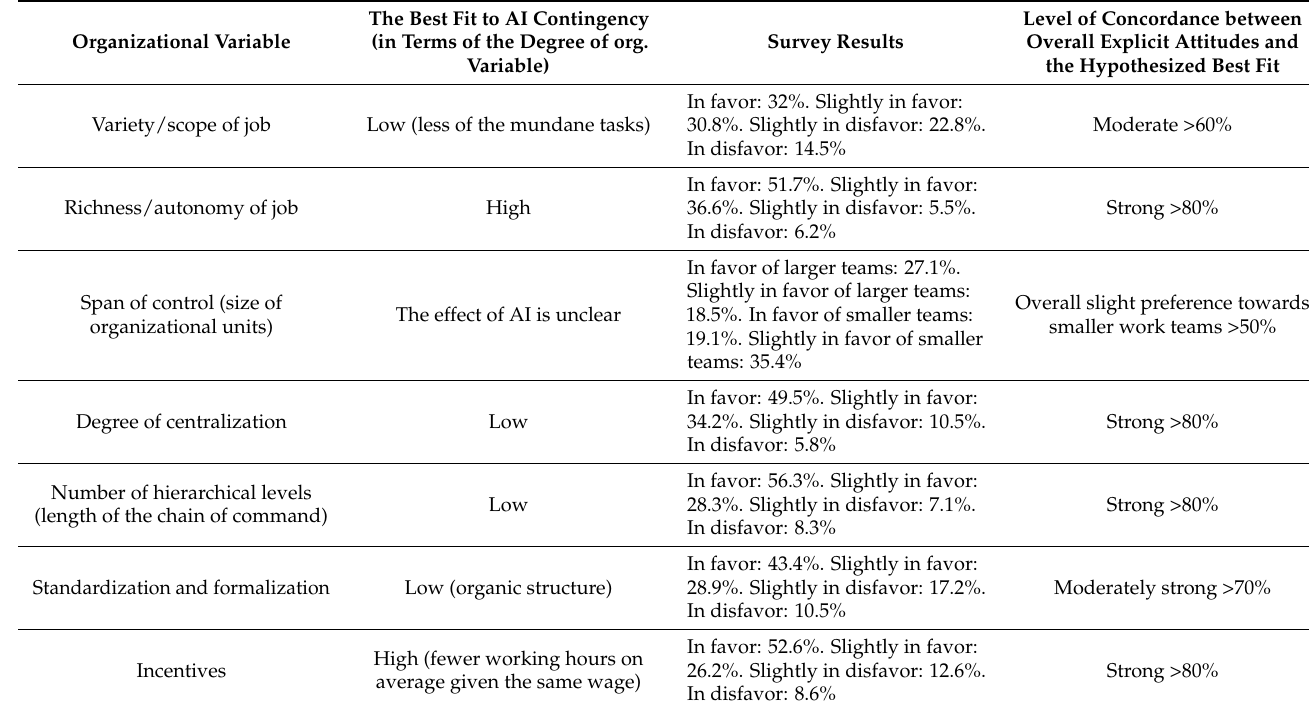
Table 4. Summary of survey